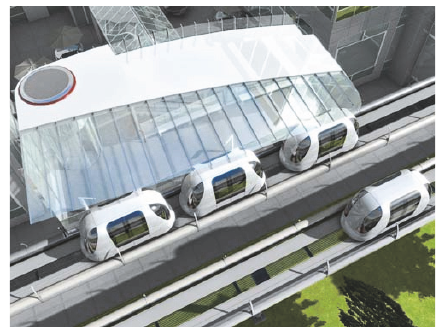
Figure2:OfflinestationofPRTsystem(source:http://www.ultraprt